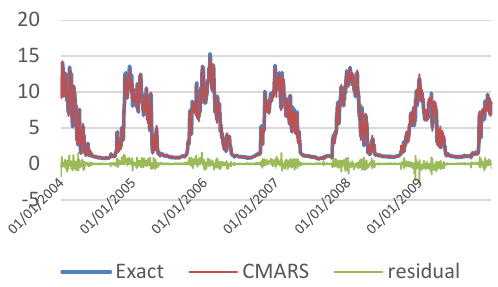
Figure 6. Exact values and CMARS approximation of natural gas consumption for one-week ahead prediction based on training data